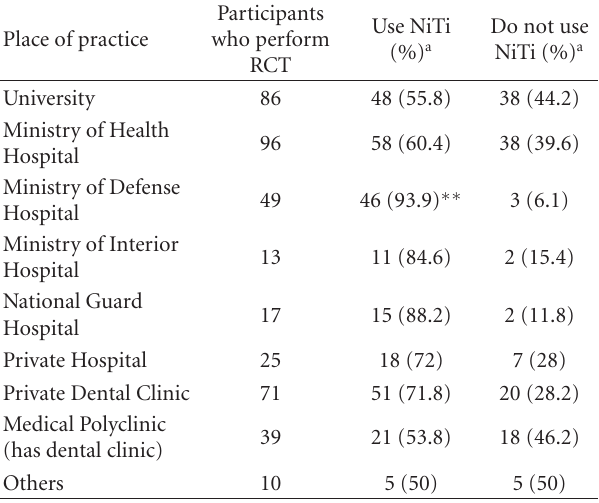
Table 6: Response details for NTRF usage and type of practice.